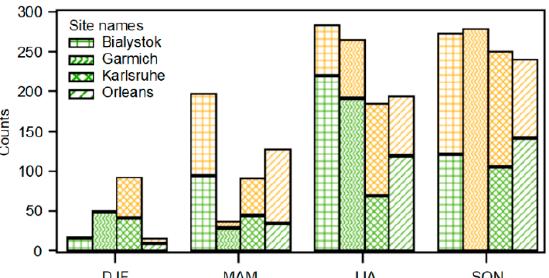
Figure 10. Statistical histogram of data amounts in different seasons and at different TCCON sites. The ordinate is the amount of data. The green pattern means the data has a certain correlation ( N HC ), while the orange pattern has a minor correlation. The orthogonal straight line indicates the data in Bialystok. The wave line in the vertical direction shows the data in Garmisch, the obliquely crossed straight line shows the data in Karlsruhe, and the oblique straight line represents the data in Orleans.